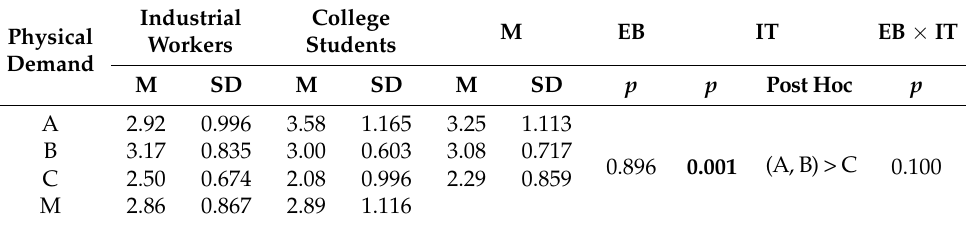
Table 6. Descriptive statistics and two-way ANOVA on the physical demand by